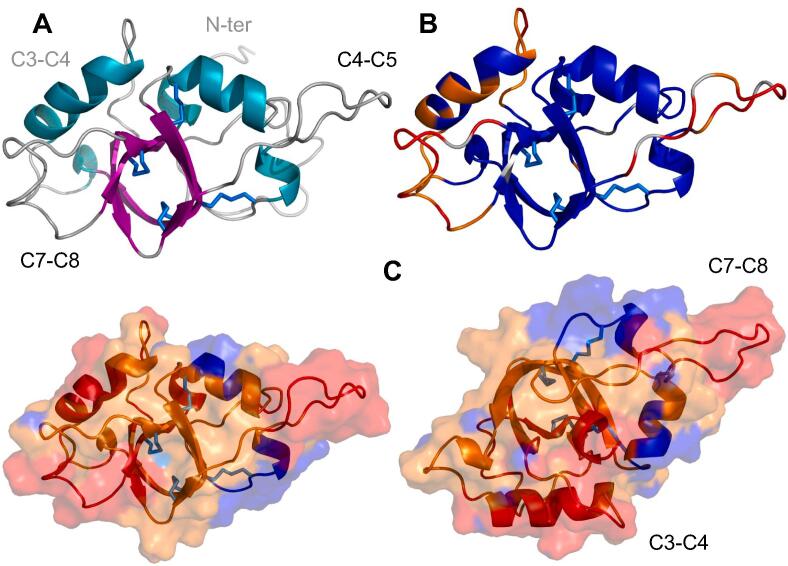
Structure (A), internal dynamics (B) and hydrophobicity (C) of monomeric RodA (best energy conformer). A: Strands are shown in magenta, helices in cyan and disulfide bridges in marine blue. The inter cysteine regions on the front (grey) and back (light grey) as well as the N-terminal region are indicated. Cysteines are numbered by their order in the sequence throughout this paper. B: Backbone amide 1H-15N heteronuclear nOe values are shown on the cartoon representation of the structure: highly flexible (nOe < 0.45), flexible (0.45 ≤ nOe ≤ 0.65), rigid (nOe > 0.65) and missing-value backbone residues are shown in red, orange, blue and grey, respectively. The structure is shown in a different orientation on the right. C: The hydropathy profile calculated with the Eisenberg hydrophobicity scale (http://web.expasy.org/protscale) is color coded on the surface and cartoon representations of the structure: blue = hydrophilic (Φ ≤ −0.3), orange (−0.3 < Φ < 0.3), red = hydrophobic (Φ ≥ 0.3). The N-terminal disordered region (residues 18–38) is not displayed in B and C. (For interpretation of the references to color in this figure legend, the reader is referred to the web version of this article).